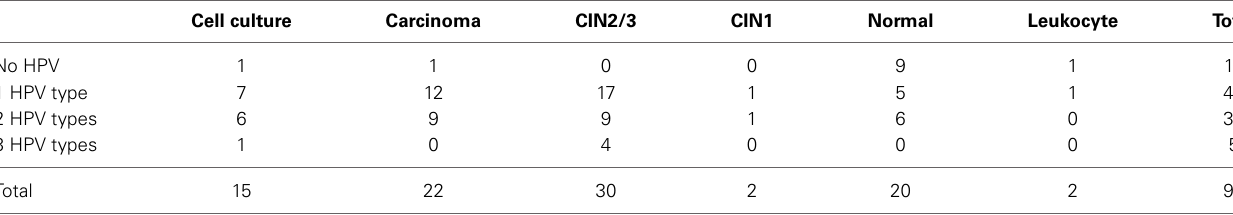
Table 4 | Overview of the number of identified HPV types in the different sample groups.